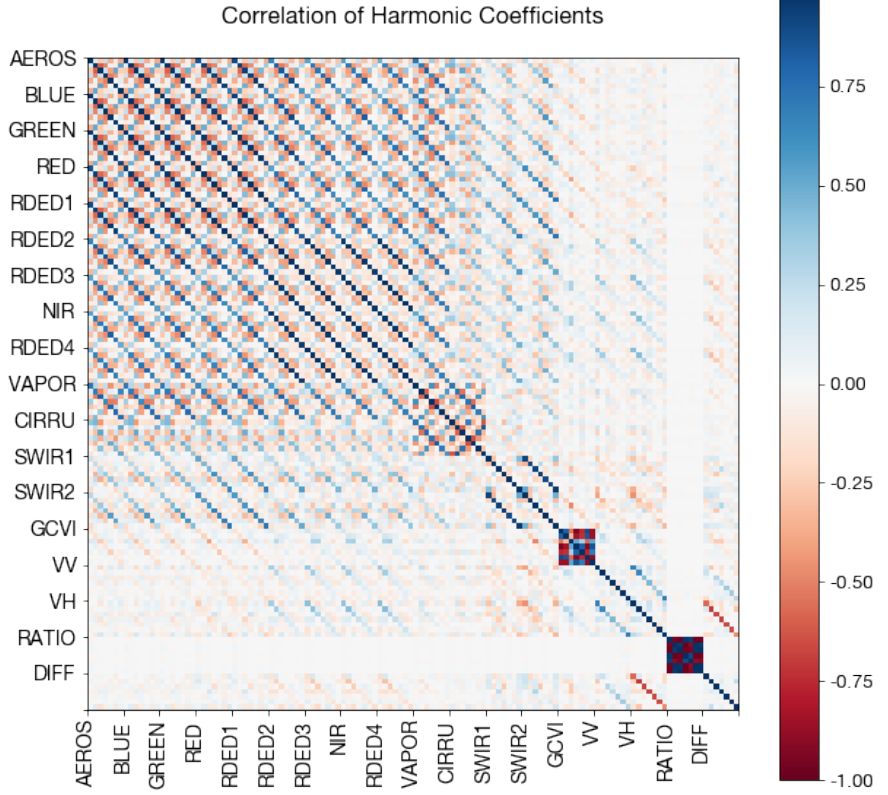
Figure A9. Correlation matrix of harmonic coefficients. The 14 Sentinel-2 bands and 4 Sentinel-1 bands are shown. Within each band, coefficients are shown in order of ascending Fourier frequency, followed by the constant ( a 1 , b 1 , a 2 , b 2 , a 3 , b 3 , c in Equation